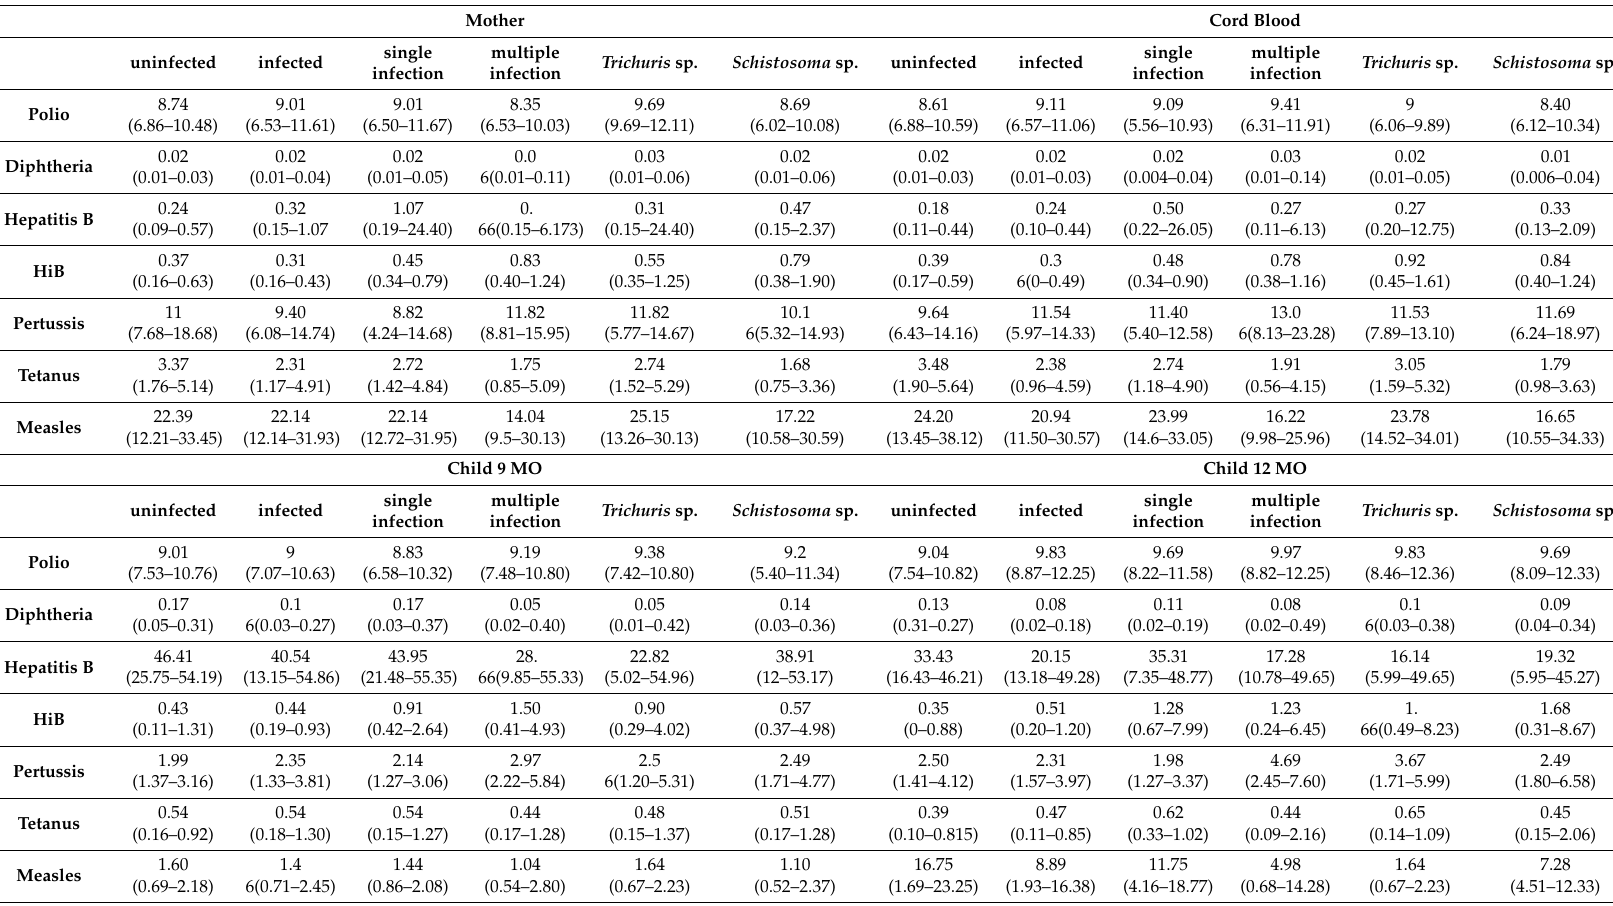
Table 2. Median values and interquartile values (25th and 75th percentiles) of vaccine-specific immunoglobulin (Ig) G levels in helminth uninfected and infected mothers, corresponding cord blood and their infants at nine months (MO) and 12 months of age. Anti-polio IgG in Units / mL; anti-diphtheria IgG in IU / mL; anti-hepatitis B IgG in fold; anti- Haemophilus influenzae type B (HiB) IgG in µ g / mL; anti-pertussis IgG in Units / mL; anti-tetanus IgG in IU / mL; anti-measles IgG in Standard Units. Infection with helminths is related to mothers only, as infants were not screened for